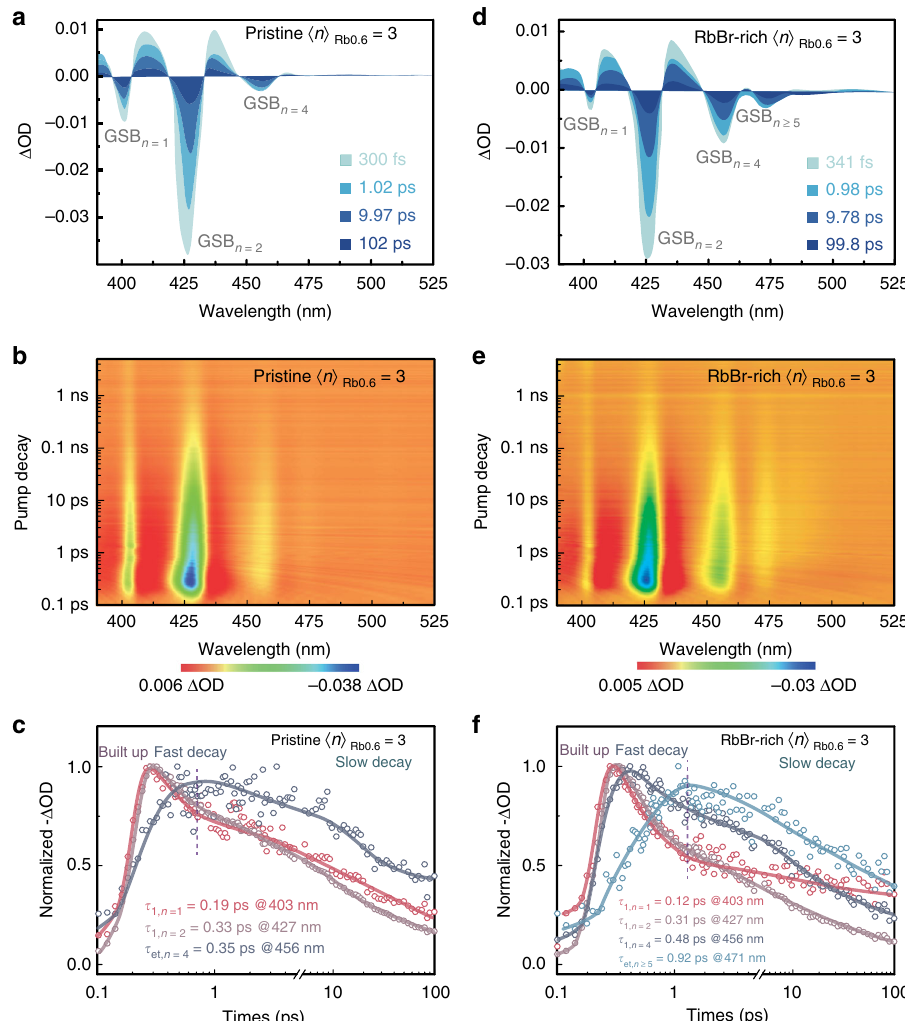
Fig. 2 TA measurements for quasi-2D perovskite fi lms. a , d TA spectra at selected timescales; b , e time – wavelength-dependent TA color maps; and c , f TA spectra at a different wavelength as a function of delay time for pristine and RbBr-rich 〈 n 〉 Rb0.6 = 3 fi lms,